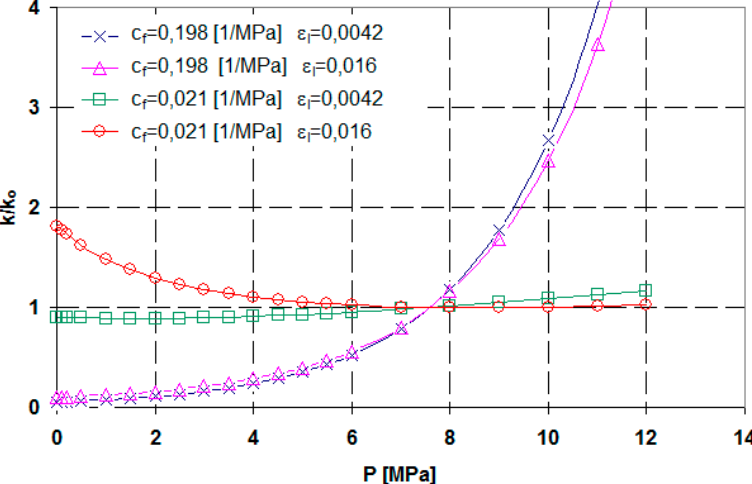
matched with the greatest and smallest changes in k / k o from previous simulations for the two 341 variants P L = 0.5 P o , and P L = 2 P o . 342